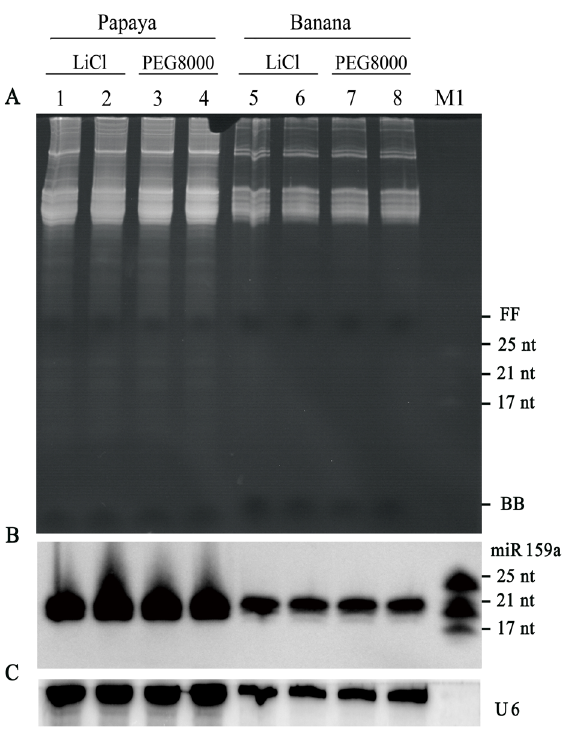
Figure 2. Analysis of small RNAs isolated from papaya and banana by the modified Trizol protocol with different precip- itation reagents. (A) Gel electrophoresis of LMW RNAs from papaya and banana obtained with different precipitation reagents by modified Trizol protocol. A total of 60 m g of LWM RNAs were run on 17% polyacrylamide gels, and visualized with ethidium bromide (EtBr) staining. (B) Northern blot assay of miR159a accumulation, respectively, and (C) U6 snRNA hybridization was used as a loading control. Lanes 1– 2 and 5–6 represent samples removing HMW RNA and DNA by PEG8000 in low salt concentration condition; Lanes 3–4 and 7–8 represent samples with selective precipitation of HMW RNA by 4 M LiCl. FF: xylene cyanol FF; BB: bromophenol blue; M1: miRNA marker.